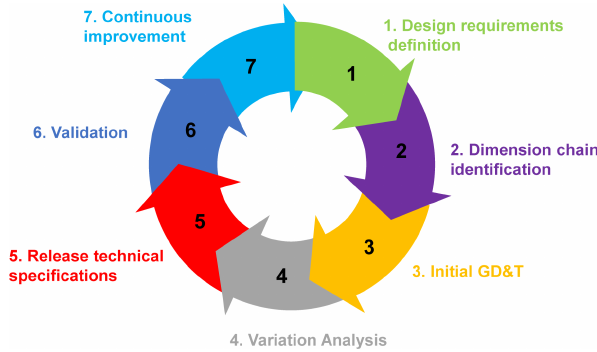
Figure 1. Cycle diagram of tolerance